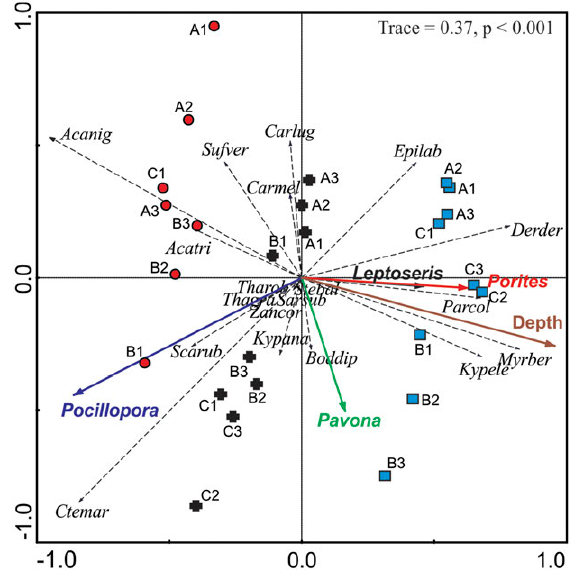
Fig. 4. – Redundancy analysis triplot and relationships among fish biomass per species, environmental variables, and transects at Clip- perton Atoll. The scientific names correspond to the first three let- ters of genus and species. Fish species are represented by arrows with thin and segmented lines. Only those species with the greatest contribution to the SIMPER analysis are shown. Environmental variables (depth and coral cover) are thick solid arrows. Transects per site and depth are represented by codes (using one letter and one number) and symbols. Letters A, B and C represent sampling sites A, B and C, while the final digit correspond to the transect number. Symbols show the sampling depths: red circles are 6 m, black crosses are 12 m, and blue squares are 20